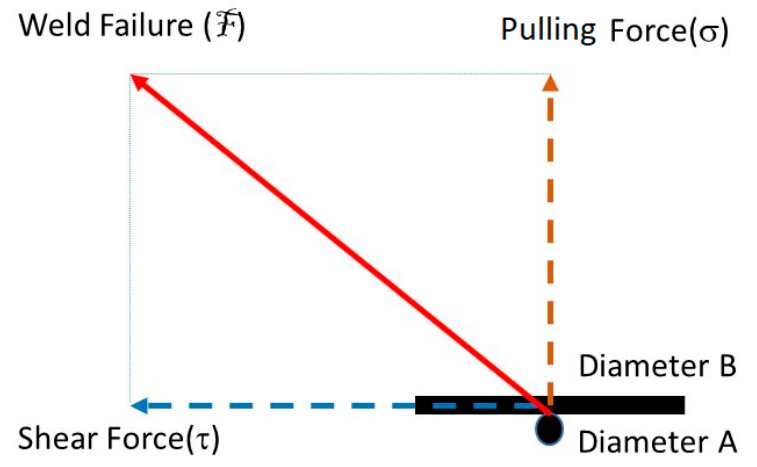
Figure 9. The force necessary for weld failure.